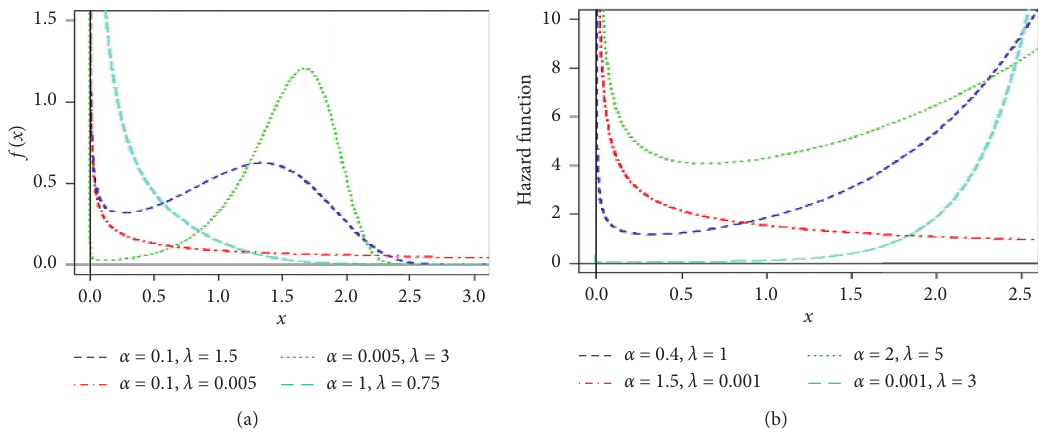
Figure 1: The PDF and HFR of RNMW distribution for different parameters’